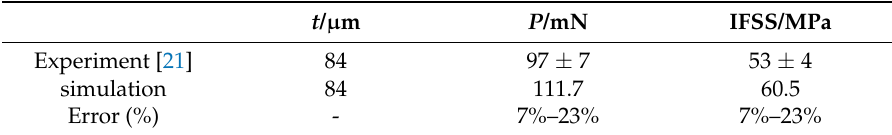
Table 3. A comparison of the experimental and simulated results of fiber ejection on the C/C composite.